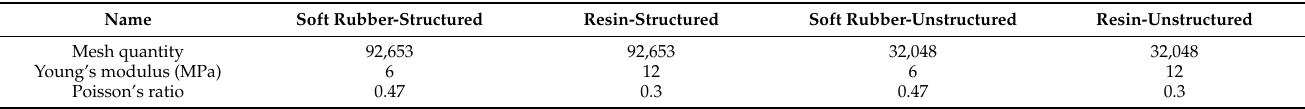
Table 1. Mesh quantity and material properties of the four bionic heel pads.